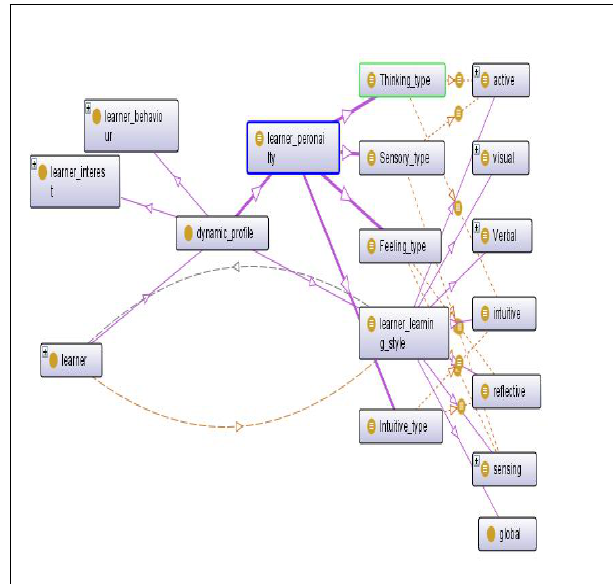
Figure 10. Modeling relationship between personality and learning style